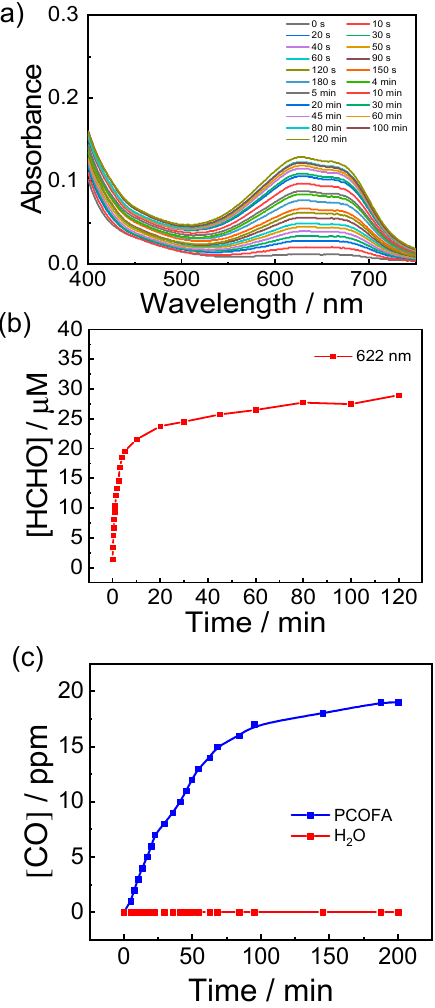
Figure 3. The UV spectra of PCOFA assembly (0.1 g/L diluted to 30.75 μ M) with FA test kit ( a ) and characteristic peak intensity at 622 nm change with time ( b ); ( c ) CO release profiles of PCO (0.1 g/L), PCOFA (0.1 g/L) and water under light illumination (410 nm, 28 mW/cm 2 ).